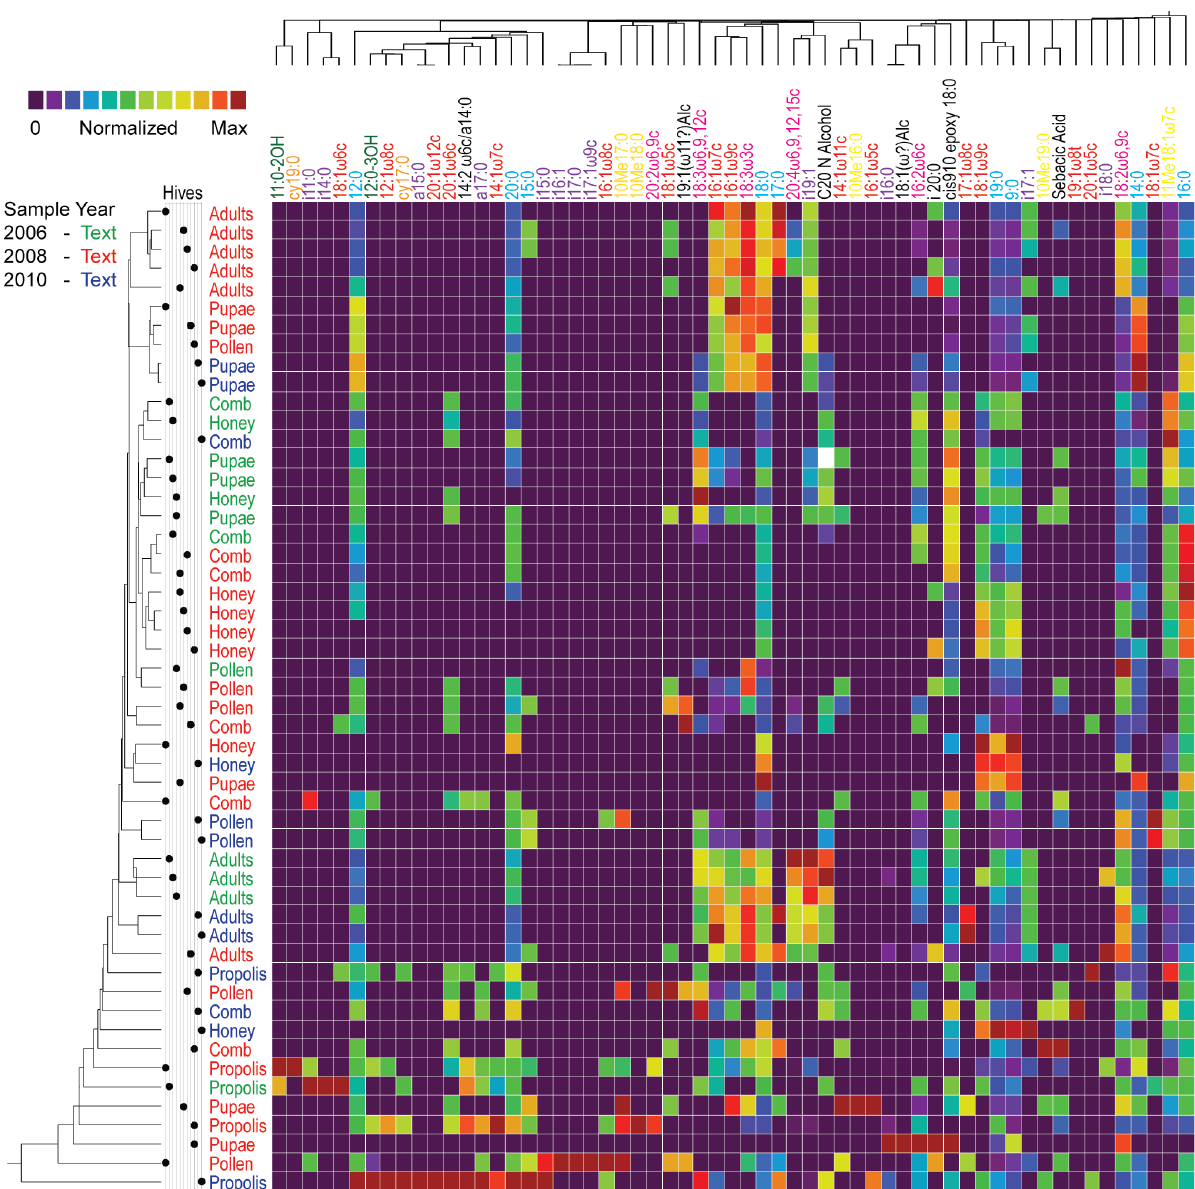
Fig 6. Heat map, dendrograms and dot plot representing both lipid and component clustering. Heatmap represents a two-way clusteringanalysis derived from lipid profiles. Vertical dendrogram represents clustering of profiles by components. This dendrogram shows components clustering together at various points inthetree. The dot plot immediately to the right of the vertical diagram represents each of theelevenhives sampled and indicates that communities are not clustering by hive as dots are not found ingroups on thesame row. Each of the sample labels are color codedto represent sampling year. Similar to component- wise consideration, there appear to be clusters by year, althoughto a lesser extent. The horizontaldendrogramat the topof the figure represents individual lipids. Clustering canalso be observed when considering general lipid division, e.g. themonounsaturated fatty acids grouptogether. Fatty acid coloring: hydroxyl, green; cyclic, orange; branched, purple; monounsaturated, red; saturated, blue; methylated, yellow; polyunsaturated, pink; unclassified,